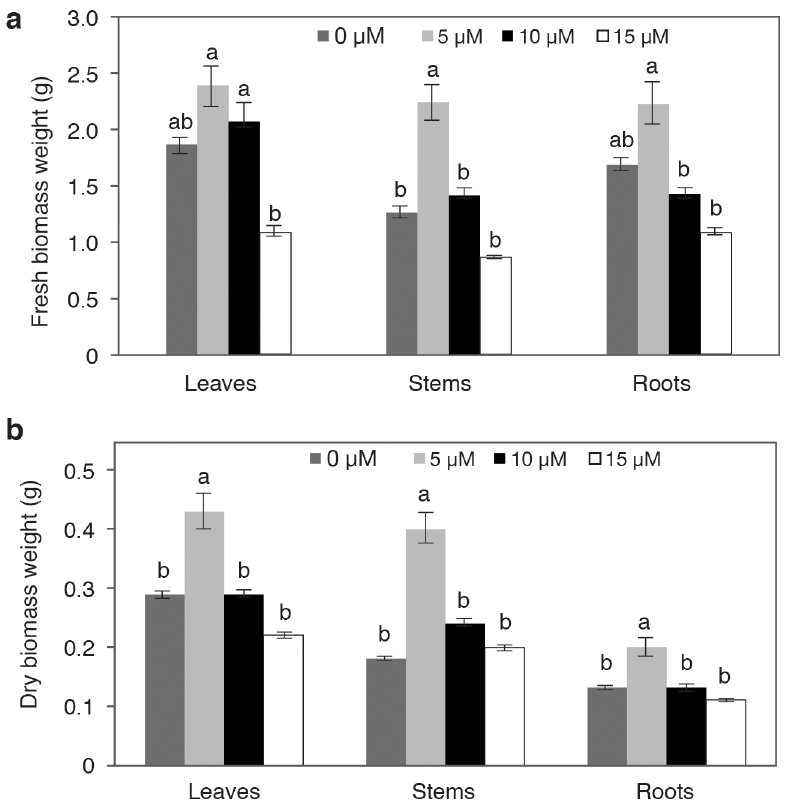
Fig 4. Fresh (a) and dry (b) biomass weight of leaves, stems and roots of pepper plants grown in nutrient solutions containing different concentrations of vanadium (0, 5, 10 and 15 μ M V) measured 28 days after treatment application. Values are means ± standard error (SE) from at least five individual plants. Different letters above the bars for individual plant parts indicate significant differences (Duncan, α =